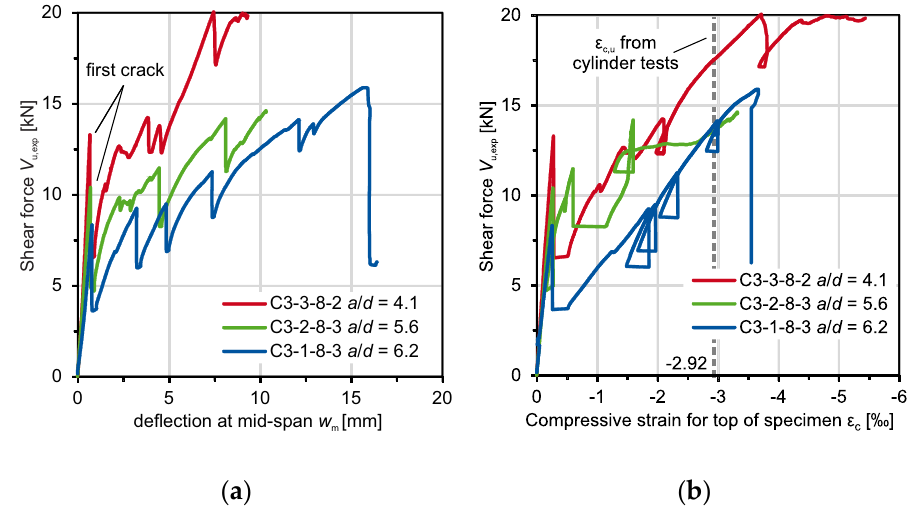
Figure 4. Experimental results for three typical specimens with d = 8 cm. ( a ) Load-deflection diagram; ( b ) load-compressive strain diagram (strain gauge at the top of the specimen in mid-span).